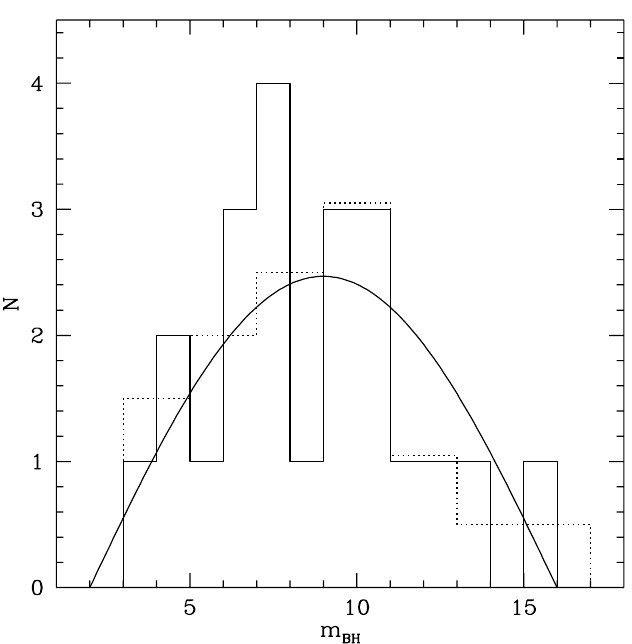
Fig. 1. Black hole mass distribution. Histograms represent mass distribution from Cherepashchuk (2011): solid lines { original data, dotted lines { two-bin smoothed data. The solid curve represents the approximation of the data by Equation